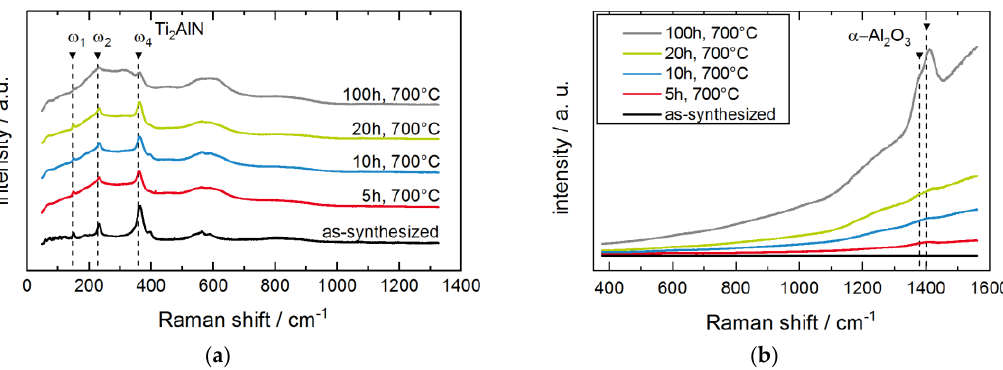
samples: (a) overview and (b) enlarged region around 2θ° ≈ 40°. ( a ) overview and ( b ) enlarged region around 2 θ ◦ ≈ 40 ◦ .